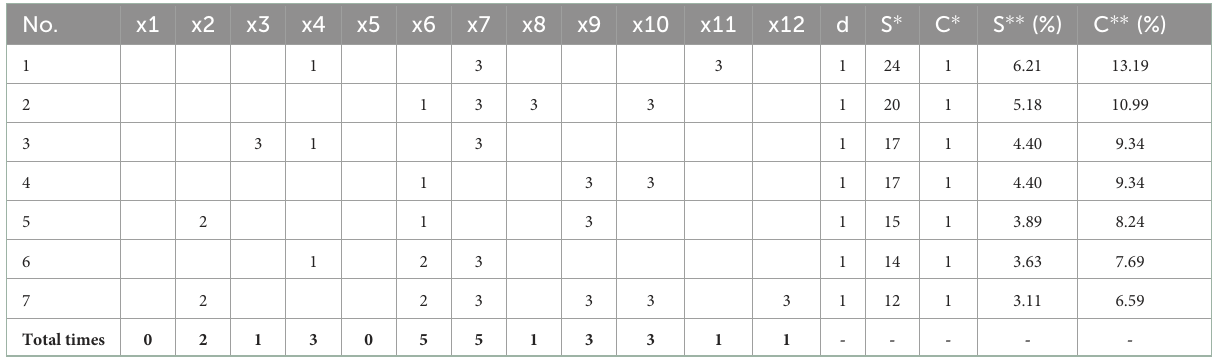
TABLE 6 Decision rules of low intention to use GMFs with minimum support value ≥